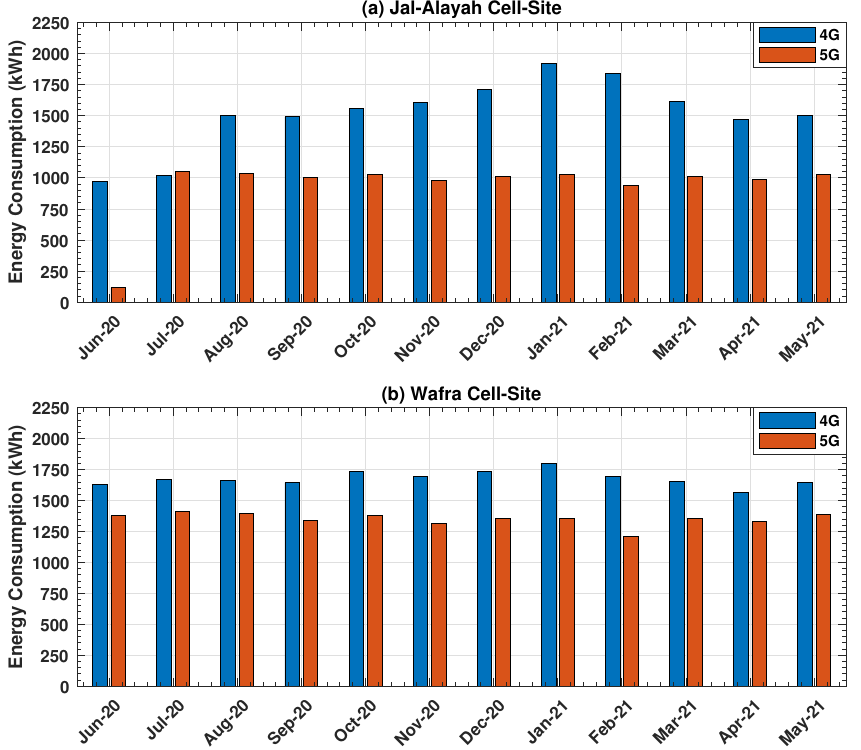
Figure 7. Base-station DC load profile at: ( a ) the Jal-Alayah cell-site and ( b ) the Wafra